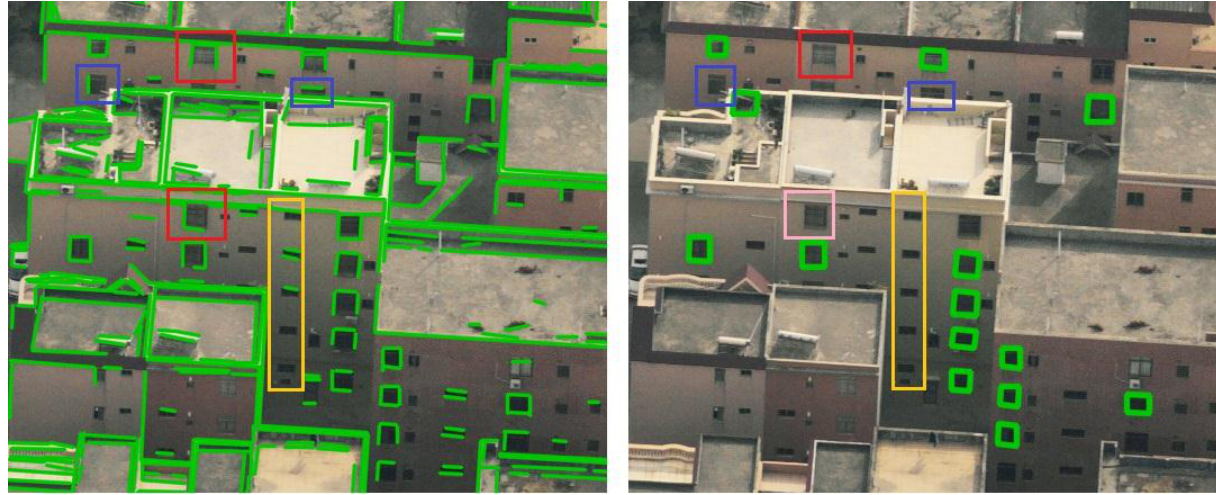
Figure 13 . Failed window regional feature extraction. The windows enclosed in red boxes are examples of self-occlusion, and the windows enclosed in blue boxes are examples of emerged occlusion; both lead to feature absence. The windows enclosed in orange boxes are examples of small windows, which also lead to feature absence. Table 1. Façade statistics of the corresponding window regional feature extraction ratio. >50% >25% >0% Failure (No) reference 73/70 23/22 22/21 7/14 target 57/52 23/20 37/34